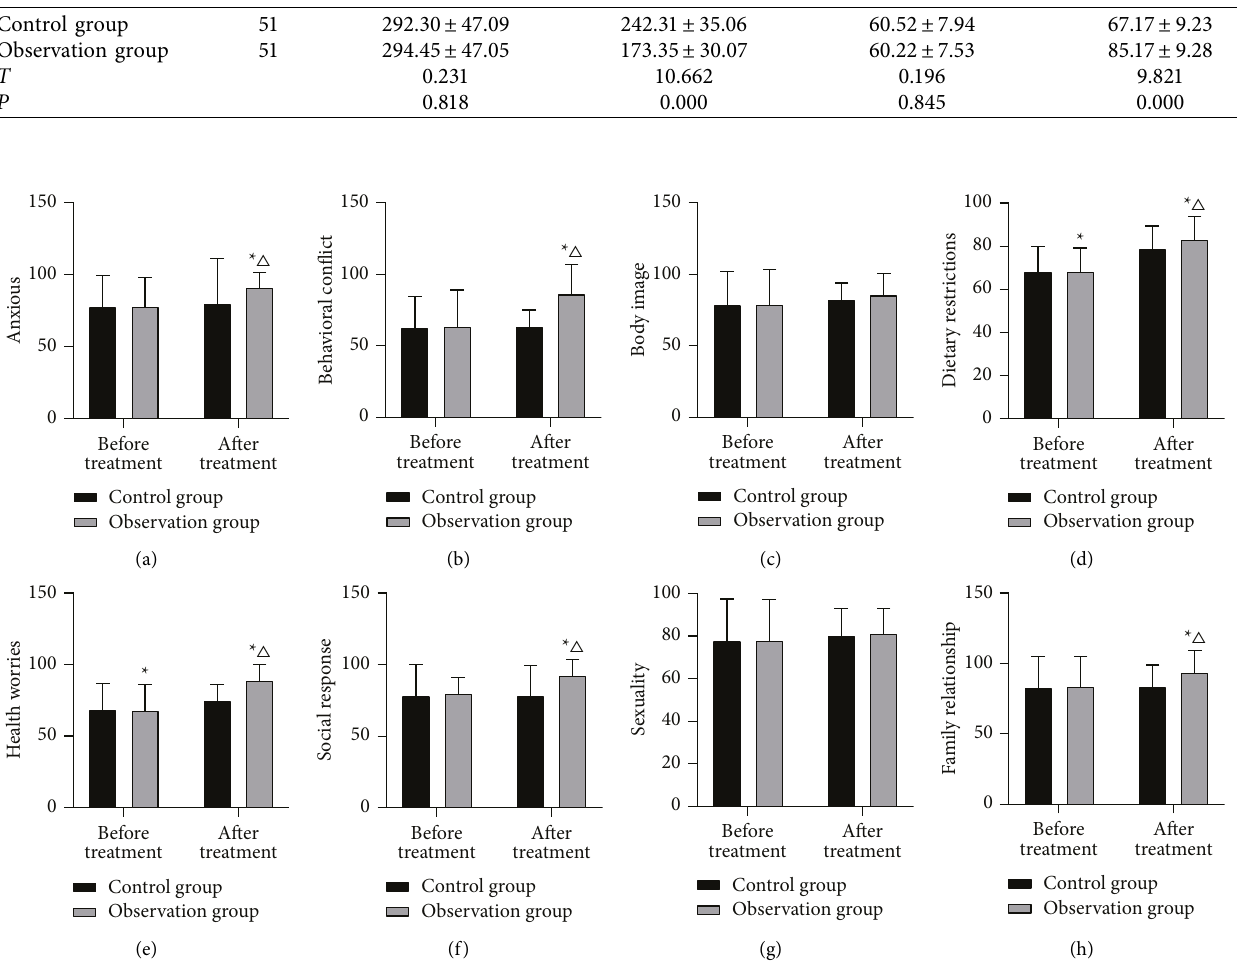
Figure 1: Comparison of IBS-QOL scores between the two groups of patients (scores, ‾ x ± s ). Note: compared with the same group before treatment, ∗ P < 0 . 05; compared with the control group after treatment, Δ P < 0 . 05. (a) Anxious. (b) Behavioral confict. (c) Body image. (d) Dietary restrictions. (e) Health worries. (f) Social response. (g) Sexuality. (h) Family